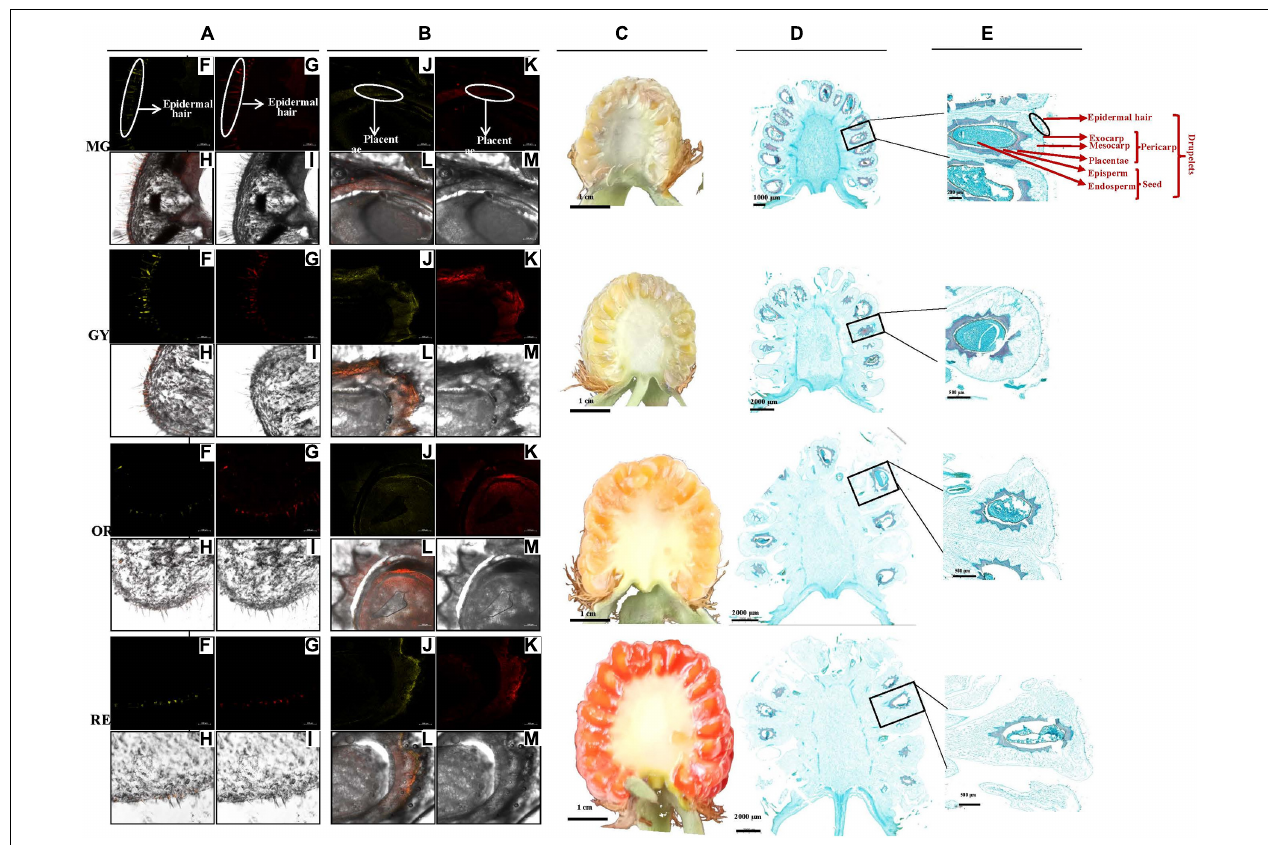
FIGURE 2 | Fruit section and in situ flavonoid staining at four maturation phases (MG to GY, YO, and RE) (Li et al., 2021a,b). (A,B) Pericarp and seed radial sections by frozen method. (C) Fruit radial sections by scalpel and (D,E) by paraffin method. Fluorescence was collected at (F,J) 475–504 nm for kaempferol and (G,K) 577–619 nm for quercetin after fresh-fruit section were stained with diphenylboric acid 2-aminoethylester (DPBA). (H,L) Flavonoid localization in inflorescences combing (F,J) and (G,K) , and (I,M) original figure without fluorescence. Flavonoid mainly accumulated in epidermal hair and placentae. The proportion of different tissues gradually changed with the maturity of the